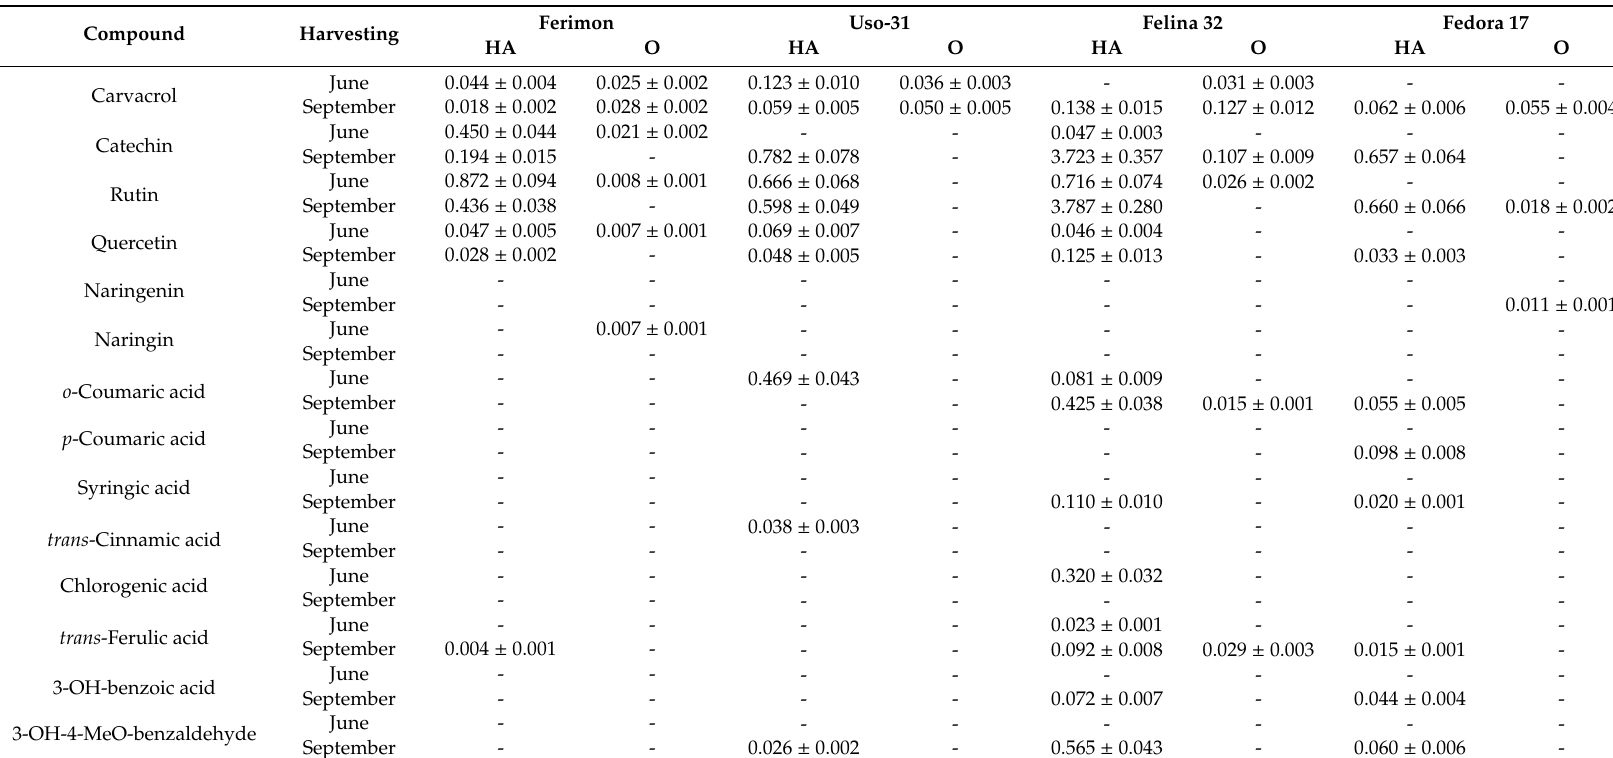
Table 5. HPLC-PDA phenolic composition of the organic (O) and hydroalcoholic (HA) Bligh-Dyer extracts from Ferimon, Uso-31, Felina 32 and Fedora 17 cultivar inflorescences harvested in June and September. Values were expressed as [ µ g / mg of fresh sample] mean ± SD (standard deviation), n =